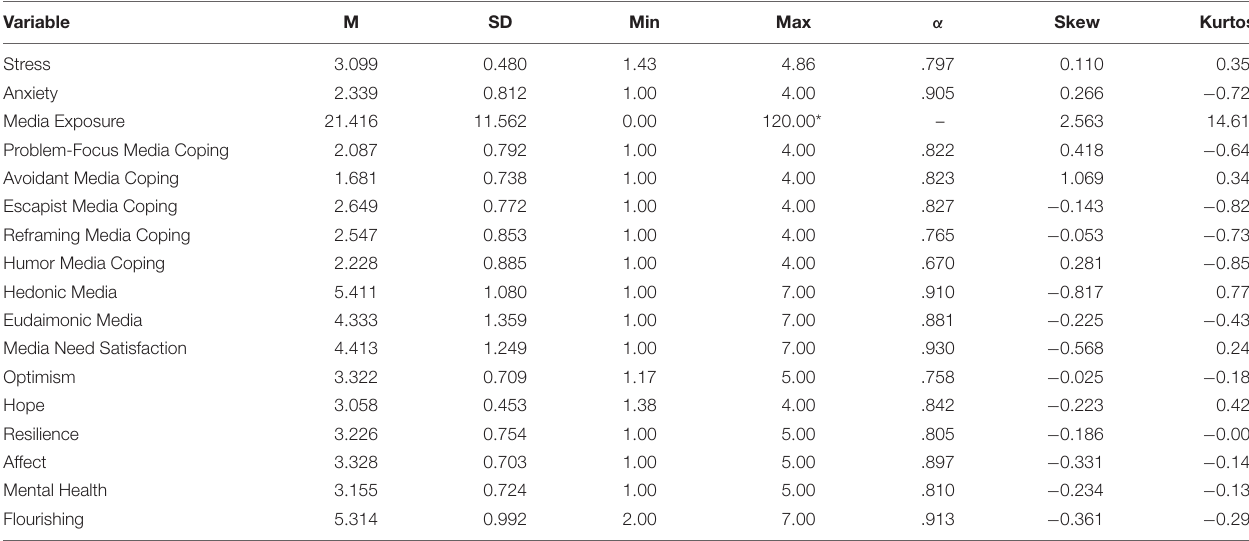
TABLE 1 | Descriptive statistics for study